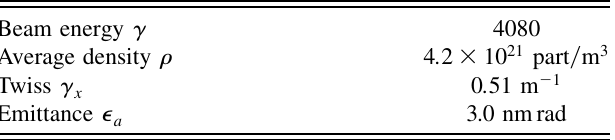
TABLE II. Nominal conditions for a bunch with 6 : 4 (cid:3) 10 10